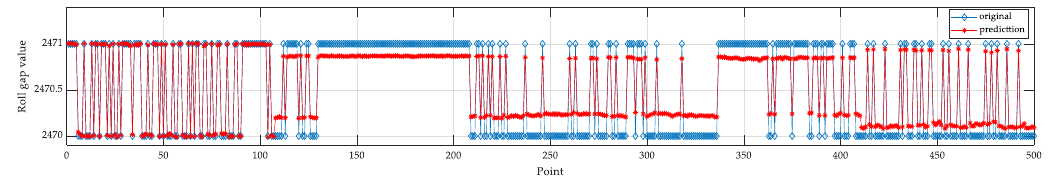
Figure 7. Prediction results of PSO-RGVP. Metals 2019 , 9 , x FOR PEER REVIEW